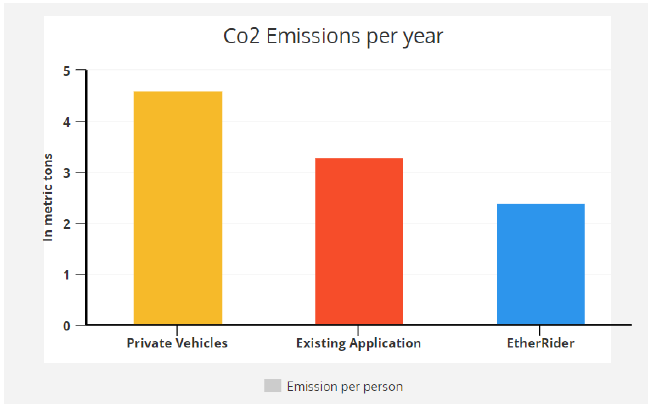
Fig10. CO2 Emissions comparison of private vehicles, existing centralized ride sharing system and proposed system decentralized ride sharing system,